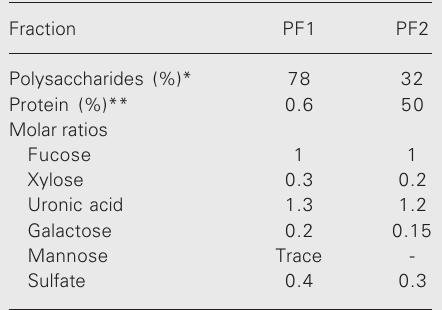
Table 2. Partial chemical composition of the polysaccharide fractions obtained from the Sepha- dex G-75